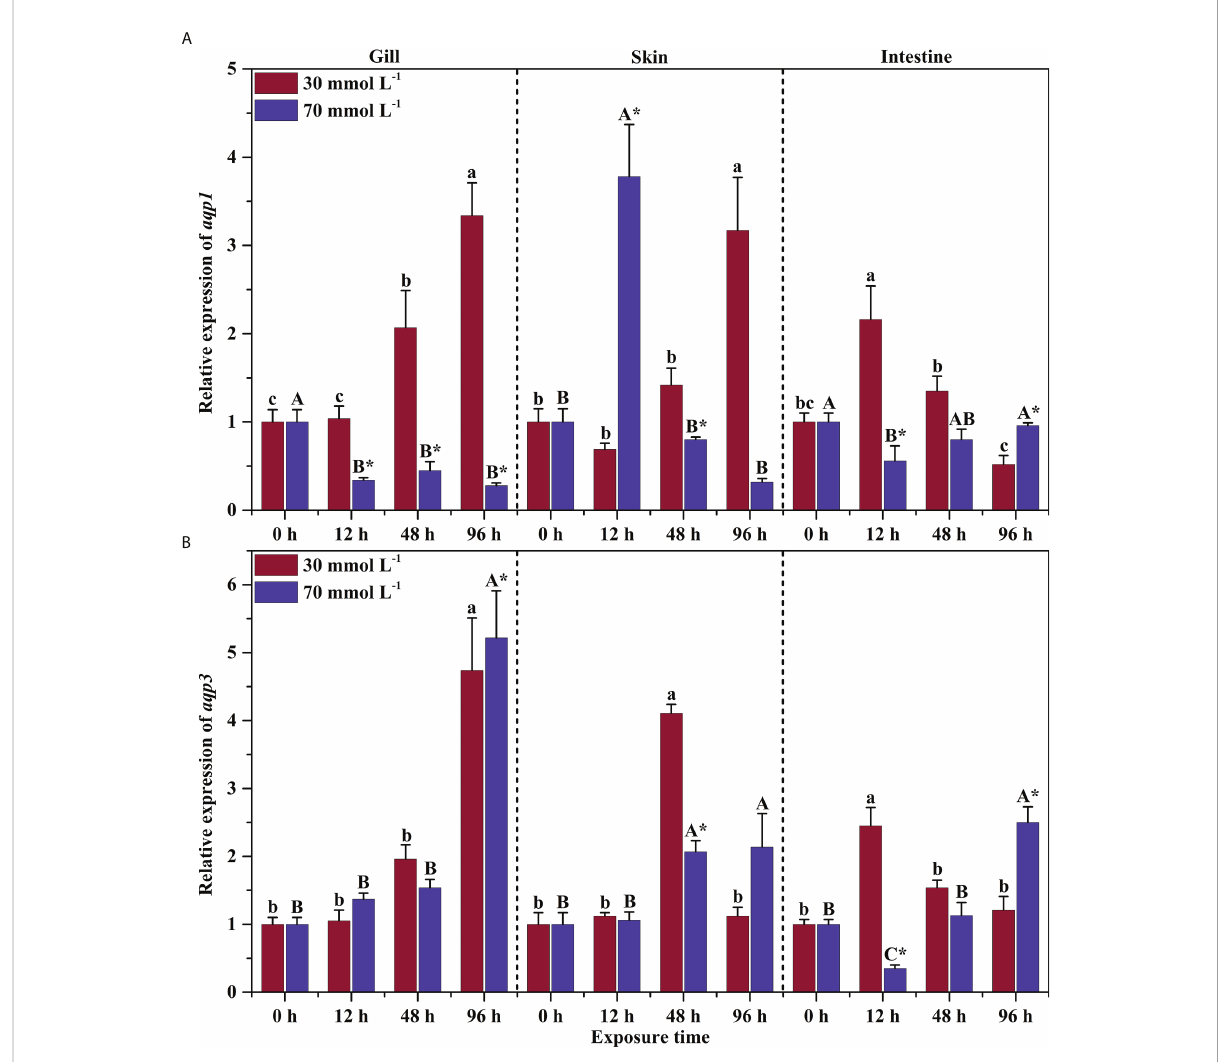
FIGURE 2 Effects of ammonia exposure on the relative expression of aqp1 (A) and aqp3 (B) in different tissues of P. dabryanus . The different lowercase letters in the same tissue are signi fi cant differences among the various periods of 30 mmol L -1 NH 4 Cl exposure. The different capital letters in the same tissue are signi fi cant differences among the various periods of 70 mmol L -1 NH 4 Cl exposure. *Signi fi cant difference between 30 mmol L -1 and 70 mmol L -1 NH 4 Cl exposure groups. The bars represent the mean ± S.E.